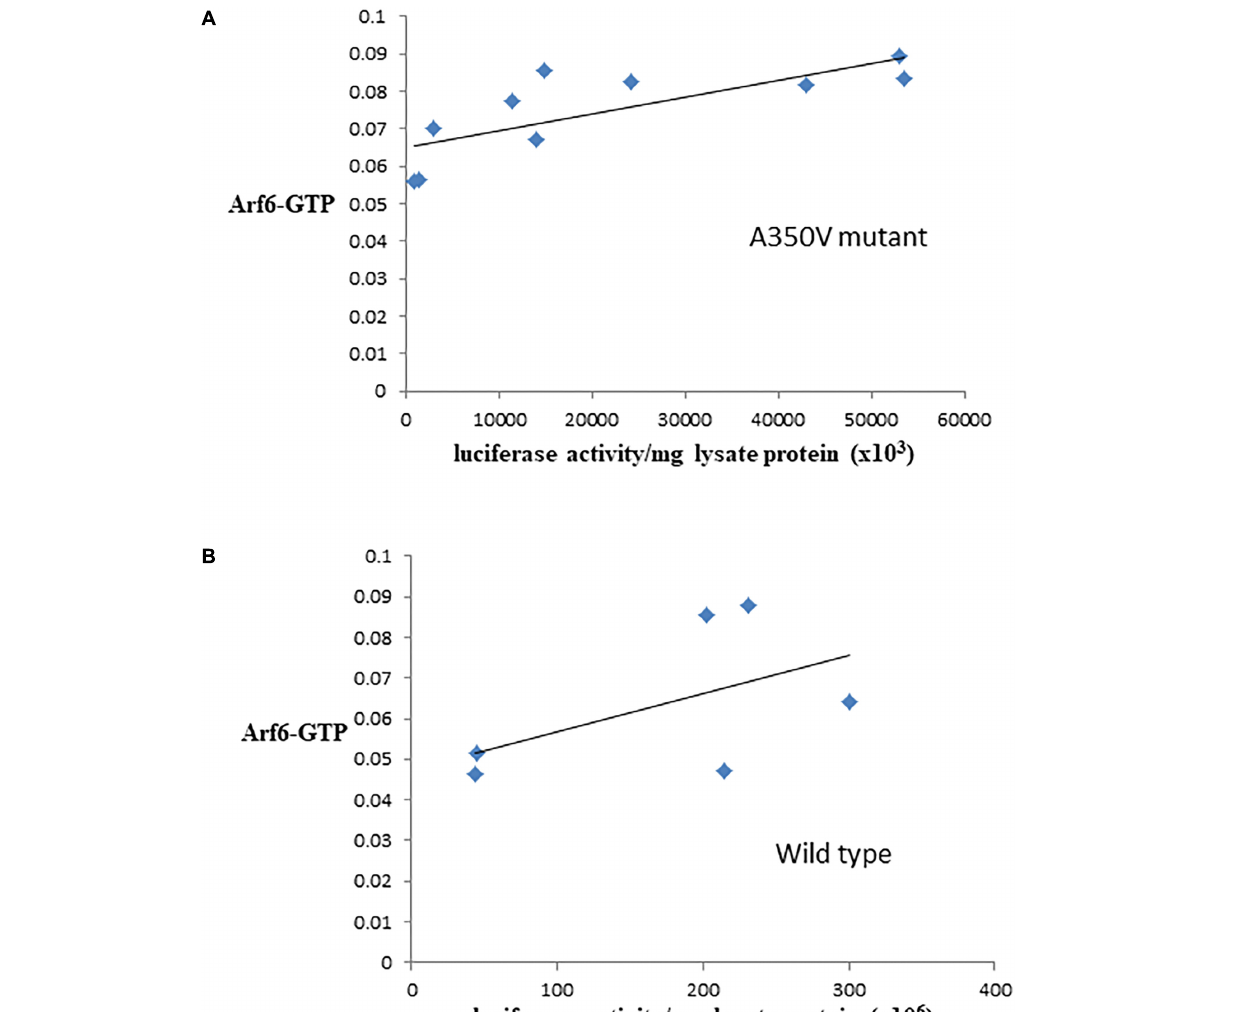
Frontiers in Molecular Neuroscience |